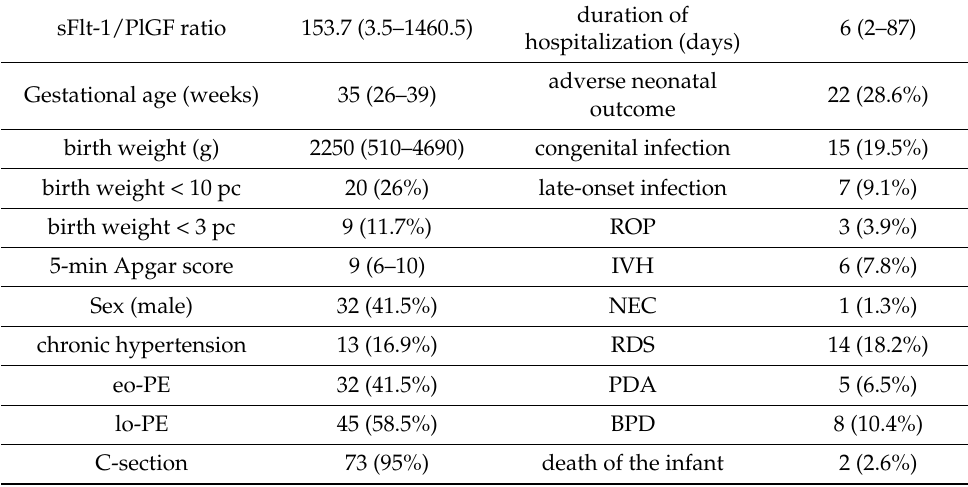
Table 1. Main characteristics of the